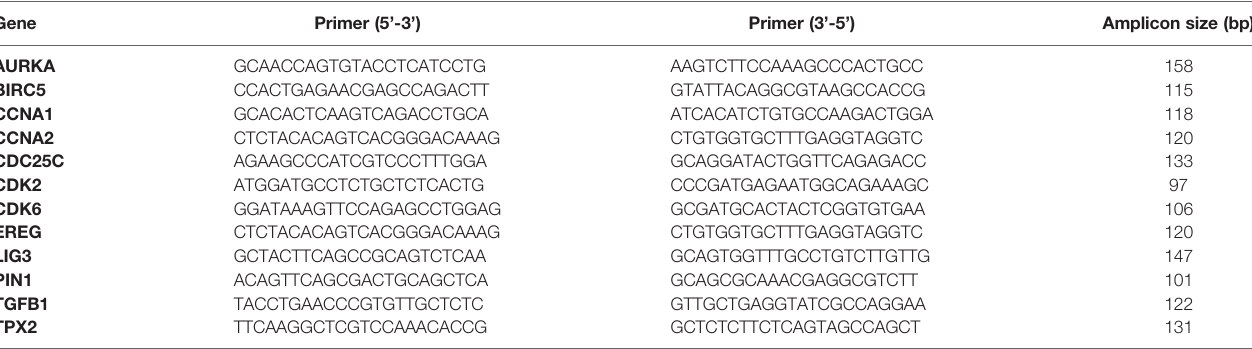
TABLE 1 | List of primers used in real-time